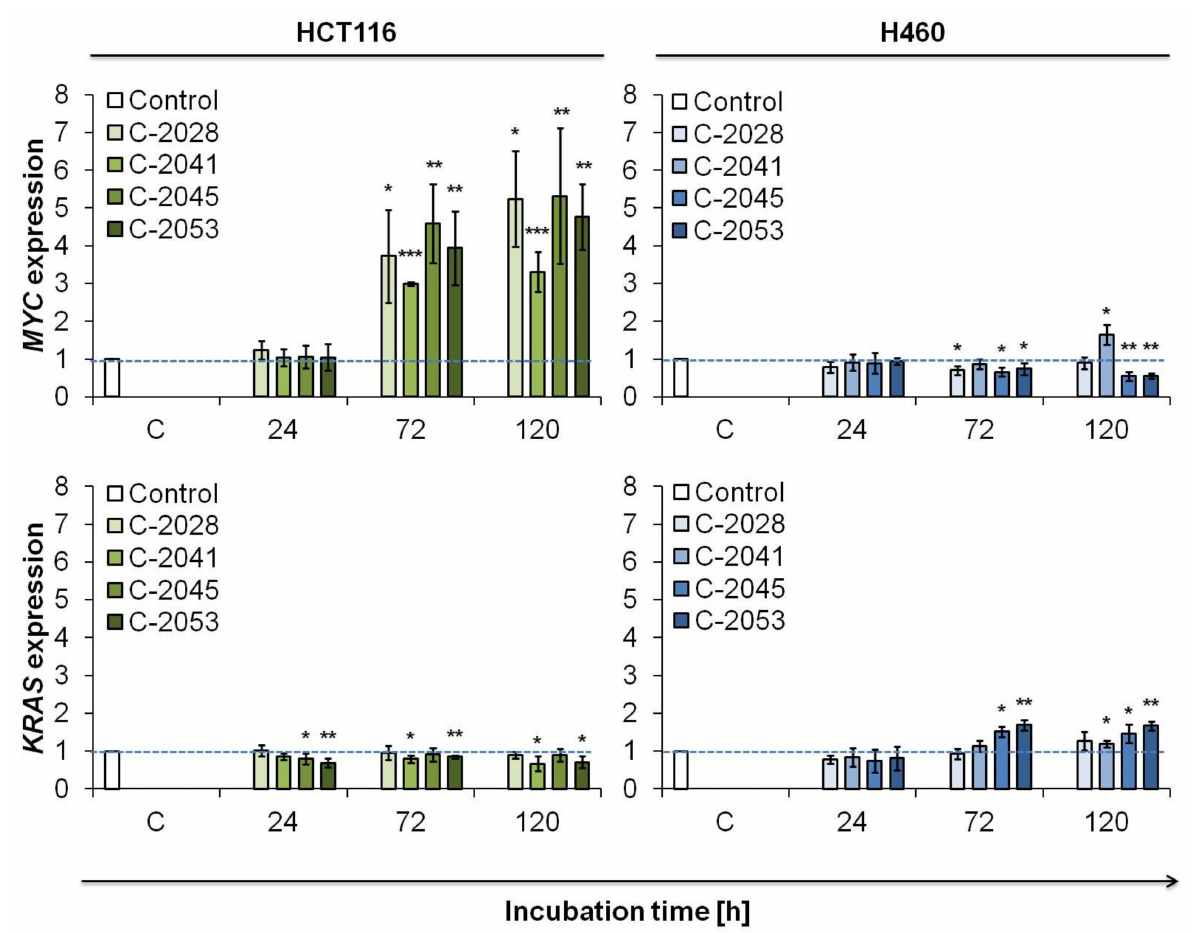
Figure 2. MYC and KRAS expression in HCT116 and H460 cells. Cells were incubated with IC 90 doses of UAs for the times indicated. Total mRNA was isolated, transcribed to cDNA, and real-time PCR analysis was performed with the appropriate primers for MYC and KRAS genes. ACTB ( β -actin) was used as housekeeping gene standard. Relative gene expression was calculated using 2 − ∆∆ Ct method [26]. Significantly different from the control at: * p < 0.05; ** p < 0.01; *** p < 0.001; ( n ≥